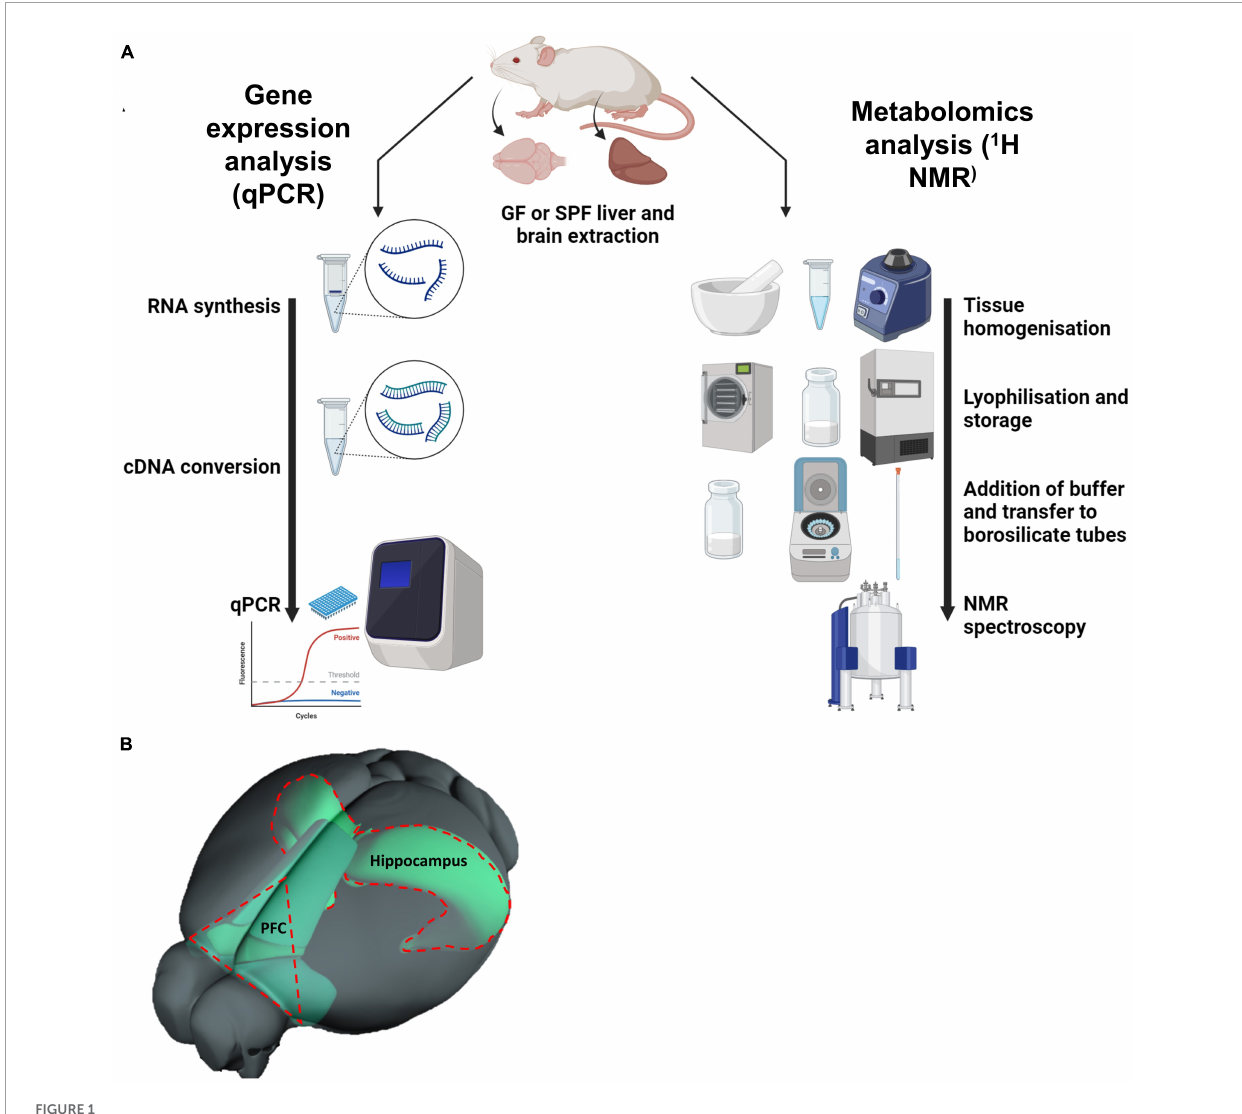
FIGURE1 (A) Diagram depicting the methodology of the project: quantitative PCR (qPCR) and 1D 1 H nuclear magnetic resonance (NMR) spectroscopy. (B) Illustration of prefrontal cortex within the mouse brain, relative to the hippocampus. (B) Is adapted from the Allen Mouse Brain Connectivity